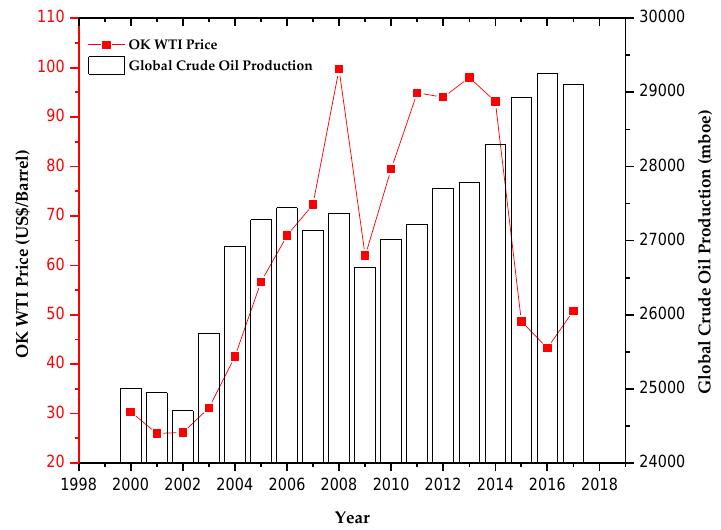
Figure 1. Crude oil price fluctuation (red line) and the annual global crude oil production rate (bar chart). OK WTI: West Texas Intermediate Crude Oil Traded in Oklahoma, adapted from [18,27].